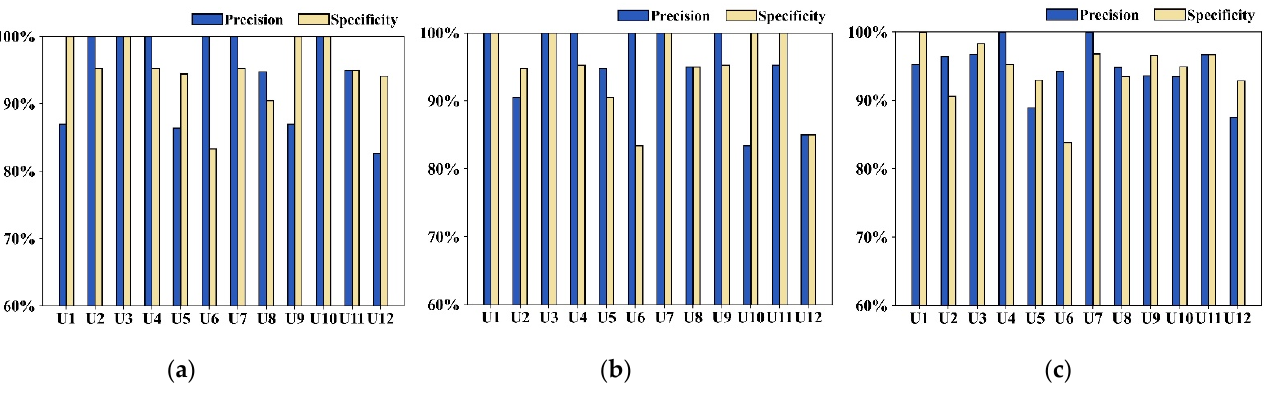
Figure 7. Performance in user attentional focus recognition at different 1RMs: ( a ) attentional focus recognition without carrying dumbbells; ( b ) attentional focus recognition lifting weight at 67% of the 1RM; and ( c ) attentional focus recognition lifting weight at 85% of the 1RM.